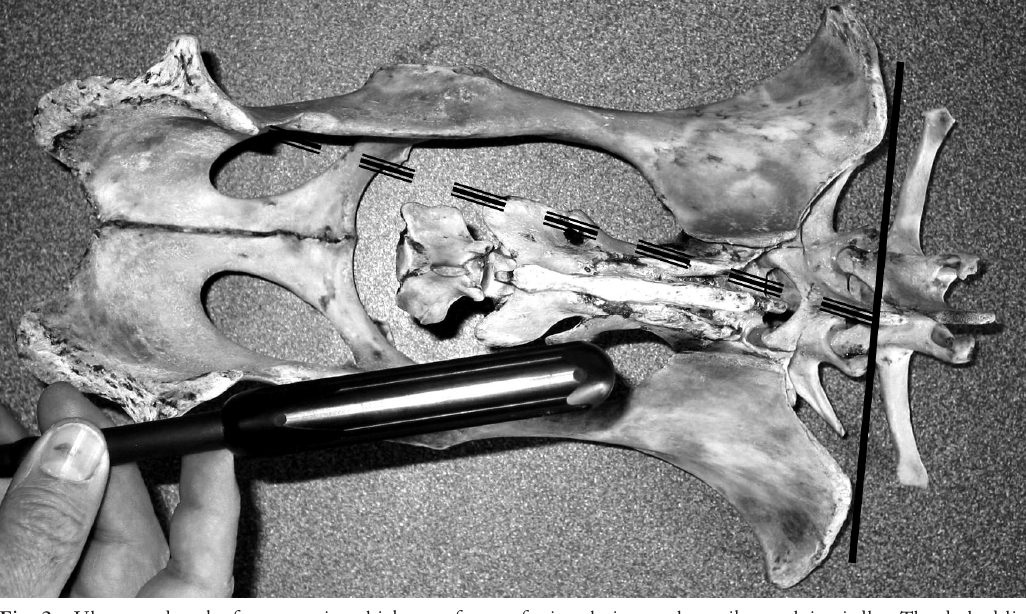
Fig. 2. Ultrasound probe for measuring thickness of rump fat in relation to the caribou pelvic girdle. The dashed line represents the line along which the ultrasound transducer probe should be positioned. The dashed line extends from the pin bone (cranial process of the tuber ischium) to a point along the spine between the hip bones (tuber coxae), as shown by the black line. Rump fat should be recorded at the point of maximum fat depth immedi- ately adjacent to the pin